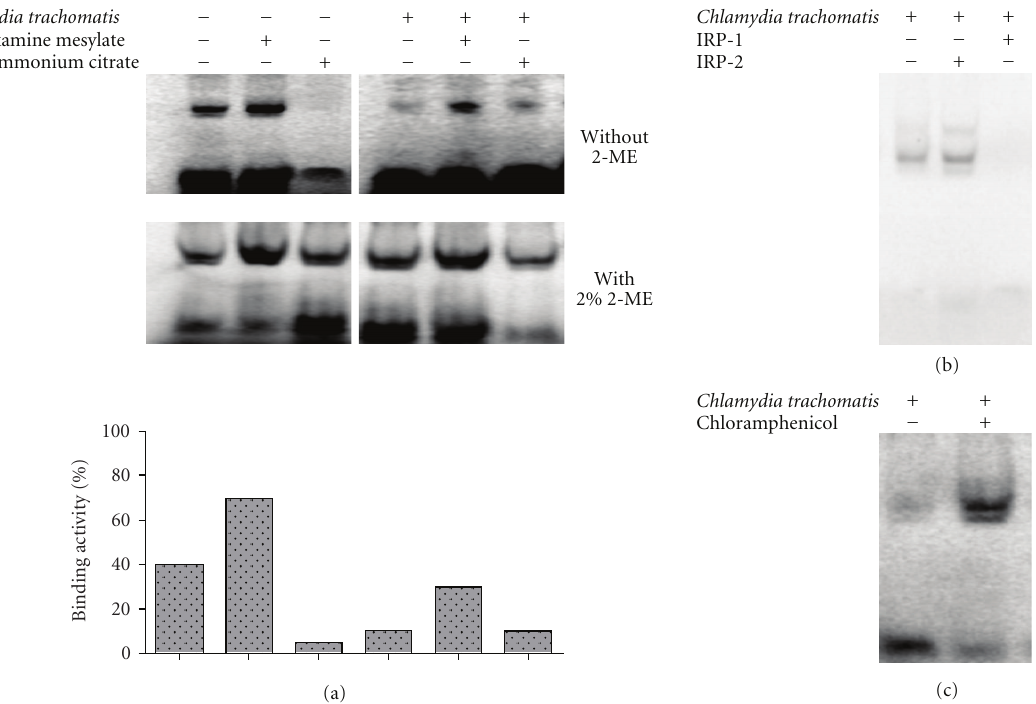
Figure 3: E ff ect of CT infection on the interaction of IRP-IRE: cytoplasmic extracts were prepared from CT-infected HeLa cells treated with DFX and FAC, along with their respective controls, at 24 hpi. Furthermore, the extracts were incubated with 32 P-labeled RNA probe, which contained the IRE sequence, in binding bu ff er. For the supershift assay, the corresponding antibodies (IRP-1 and IRP-2) were added. In parallel experiments, samples were treated with 2-mercaptoethanol) for determination of the maximum binding activity. (a) Binding activity of IRP-1/IRE was attenuated in CT-infected HeLa cells as observed in electrophoretic mobility-shift assay. (b) Inhibition of binding was observed with IRP-1 antibodies in CT-infected HeLa cells. (c) Attenuation of binding activity reverted to normal after treatment with